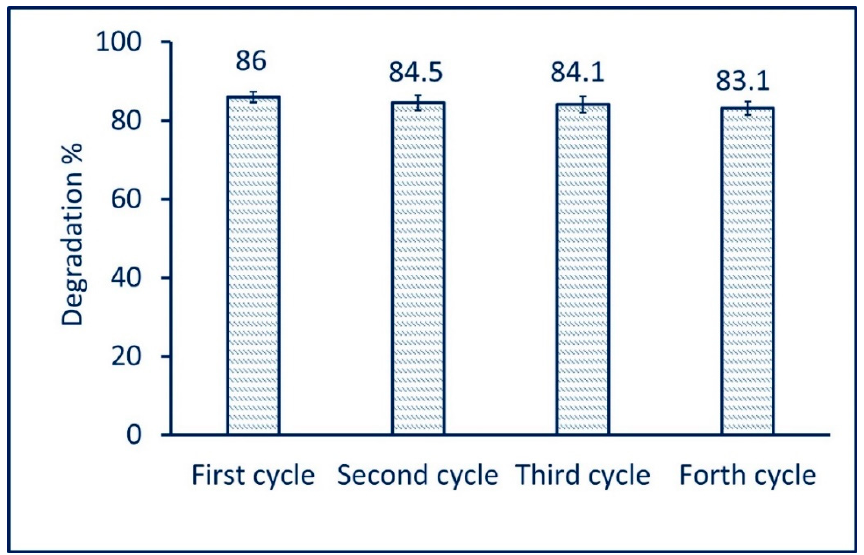
Figure 9. The reusability of green synthesized Ag-NPs for photodegradation of MB after four cycles.